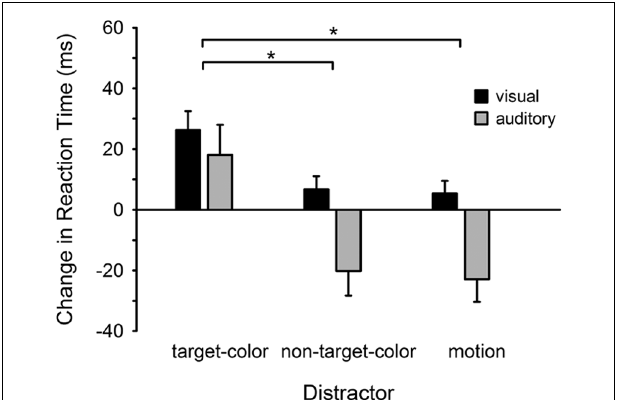
FIGURE 2 | Change in reaction time for detecting visual and auditory targets. Reaction times are plotted for each distractor condition relative to the baseline (no-distractor) condition. Reaction times were delayed following the presentation of a target-colored distractor for both the visual and auditory tasks. * p < 0.05 (corrected for multiple comparisons). Error bars show within subjects (normalized) SEM (Cousineau, 2005).